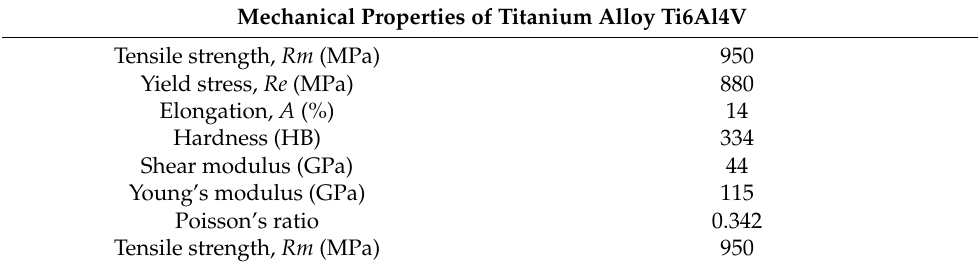
Table 1. Mechanical properties of Ti6Al4V